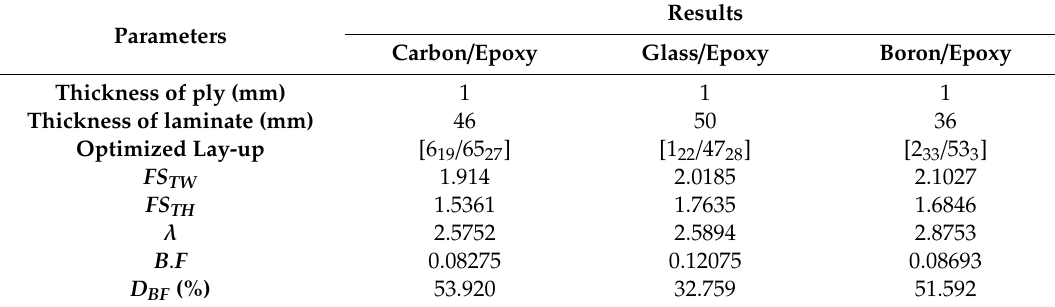
Table 7. Optimal lay-ups for [ β 1S / β 2T